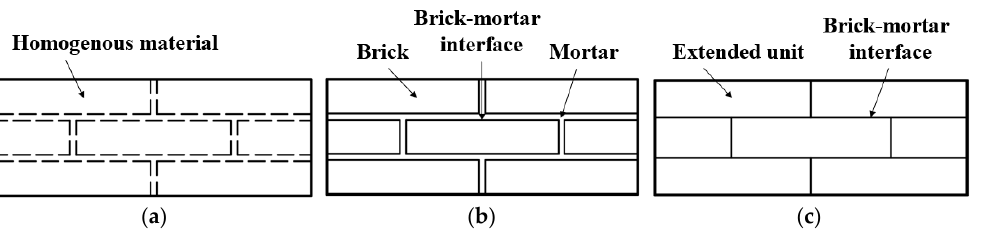
Figure 3. Modeling approaches: ( a ) separated modeling approach; ( b ) integral modeling approach; ( c ) simplified separated modeling approach